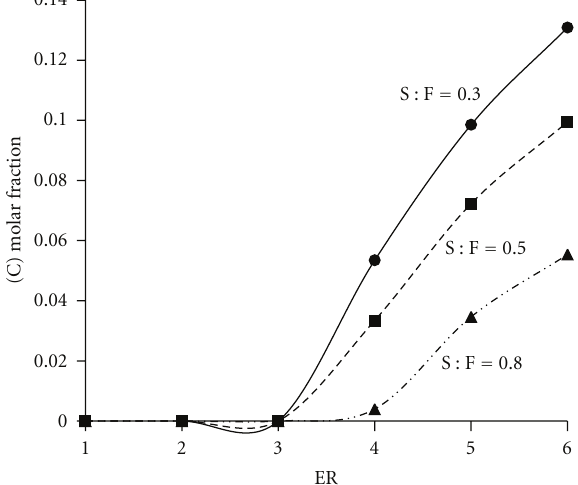
Figure 7: E ff ect of ER on Char (C) production for various S:F, estimated with chemical